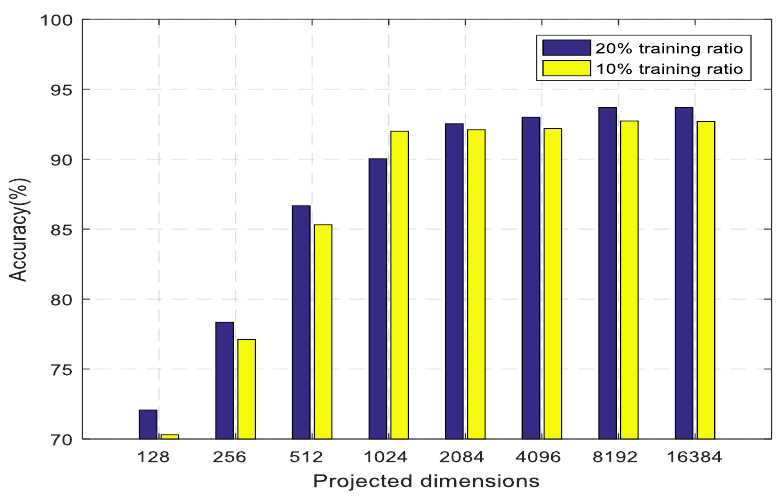
Figure 7. Influence of projected dimensions in the GCCH network.